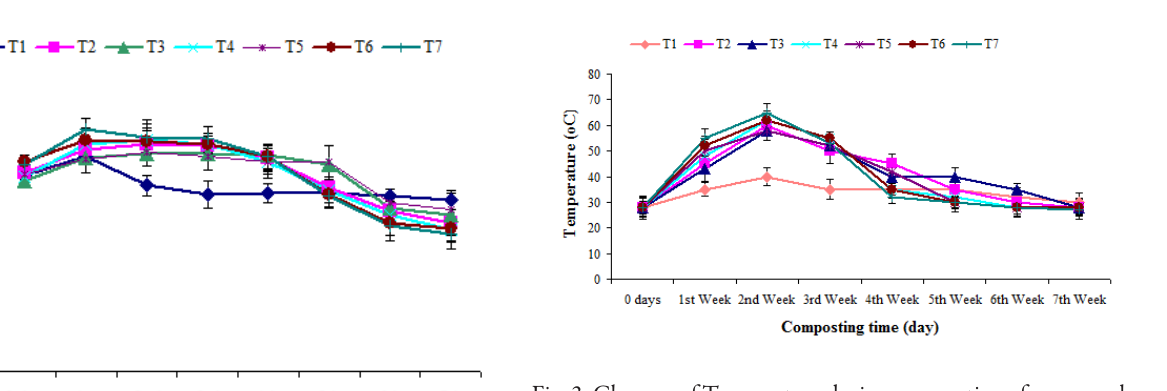
: Control (Without microorganism); T 1 : PM + Salmonella sp. + CM; 3 : PM + Klebsiella sp. + CM; T 5 : PM+ Consortium+ 7